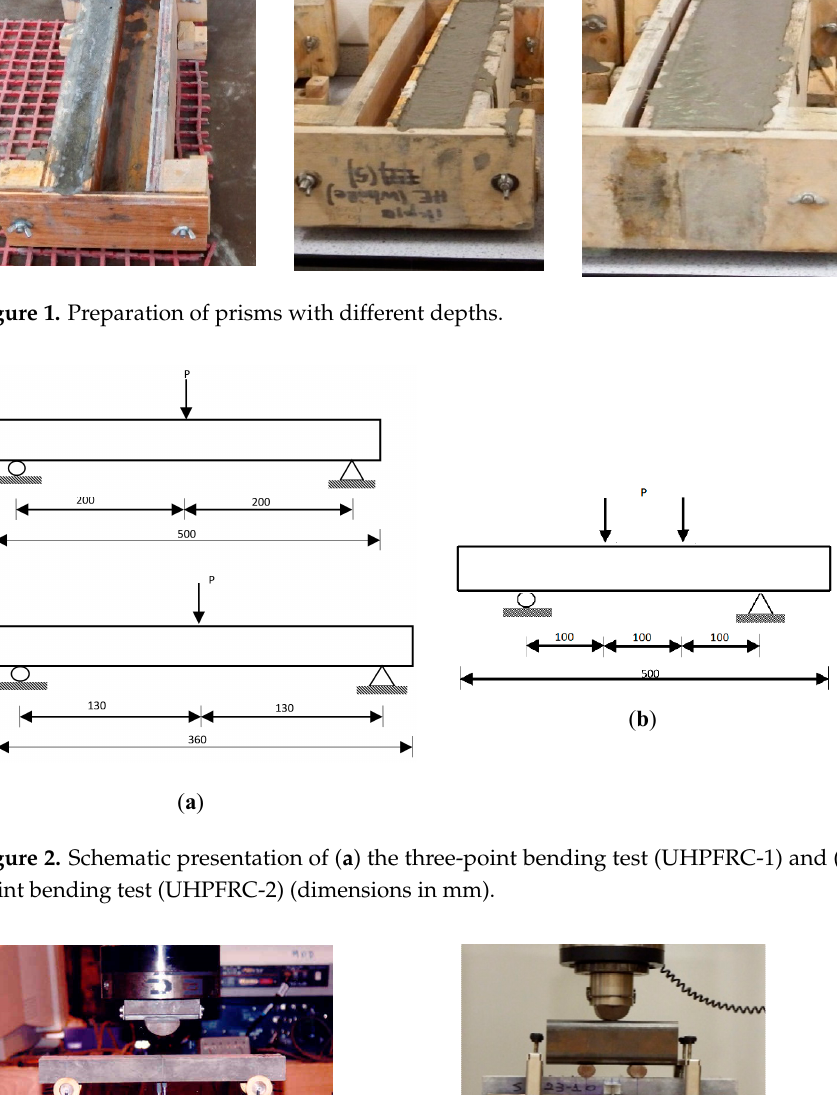
Figure 2. Schematic presentation of ( a ) the three-point bending test (UHPFRC-1) and ( b ) the four- point bending test (UHPFRC-2) (dimensions in mm).